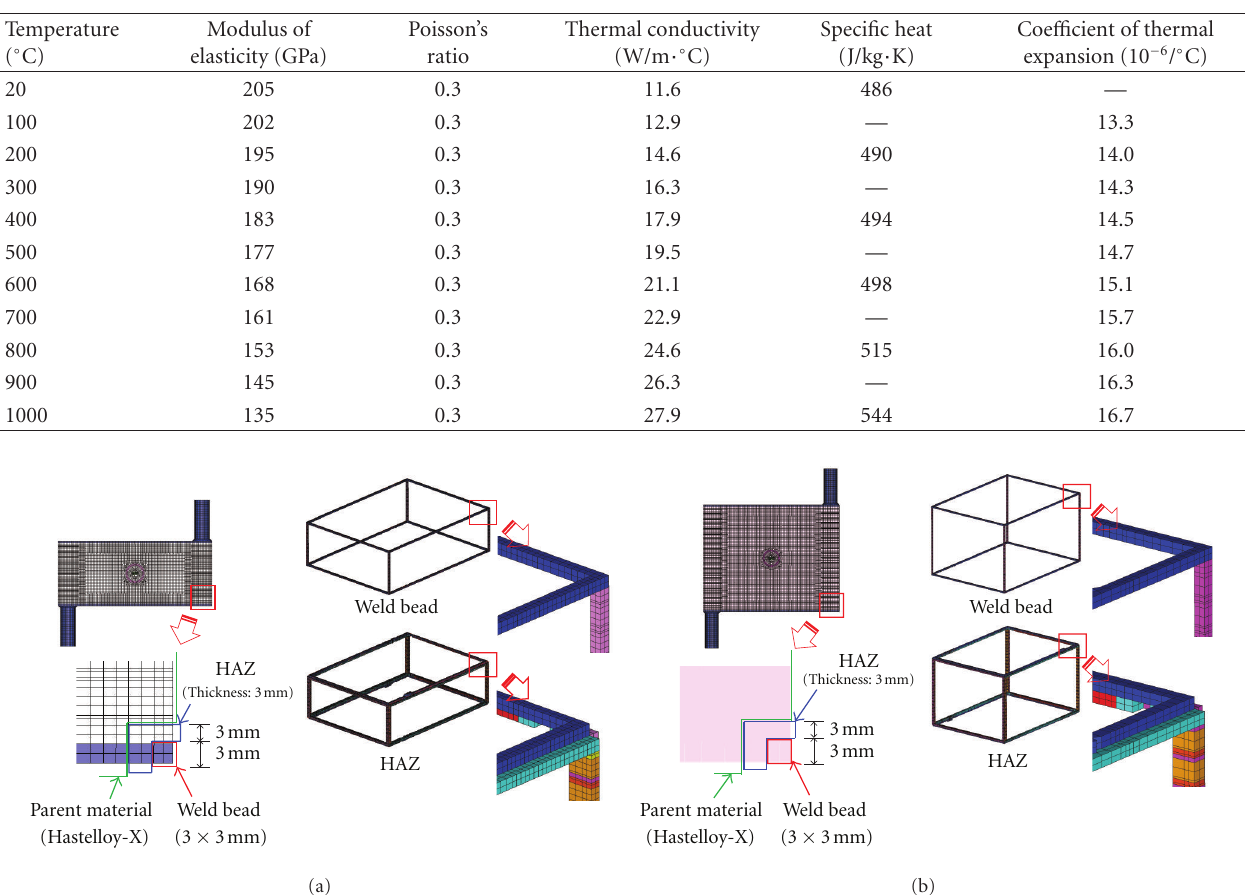
Figure 6: FE models in the weld: (a) 3 kW class PHE prototype and (b) 10 kW class PHE prototype.